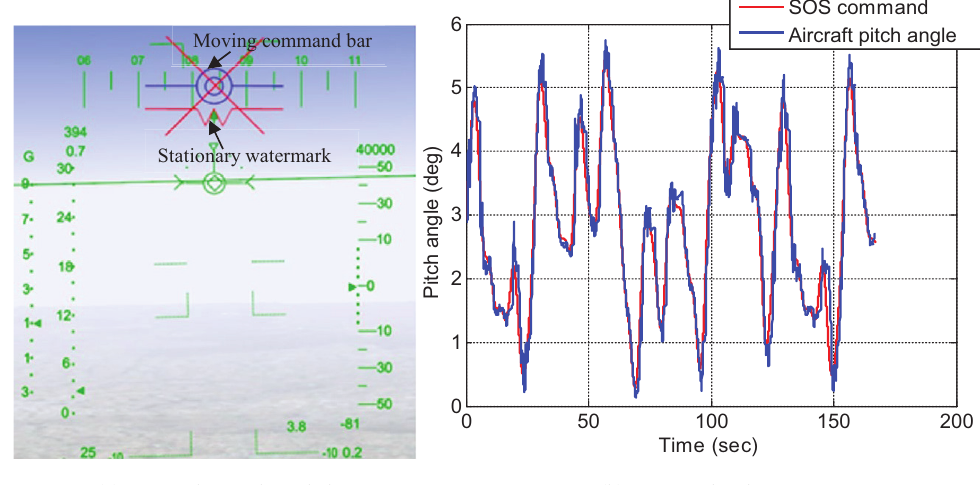
Figure 7. Pilot tracking the Sum of Sines